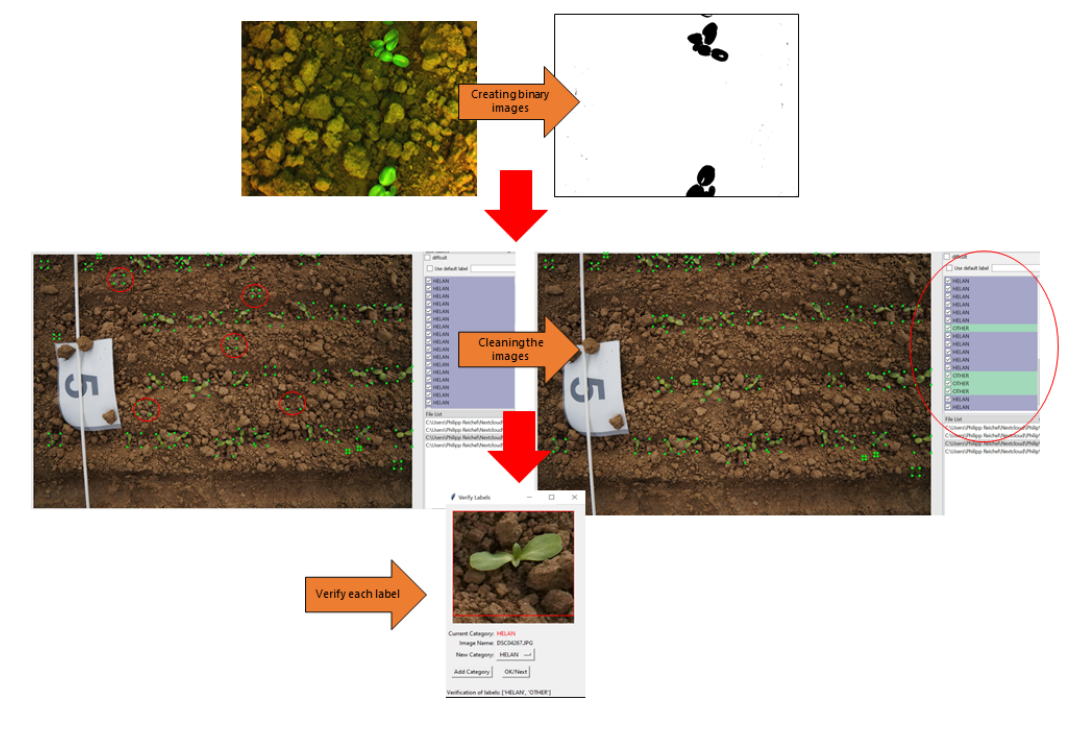
Figure 1. Schematic presentation of the labeling workflow using the example of Helianthus annuus . The final dataset was cross examined a second time by a human expert for possible